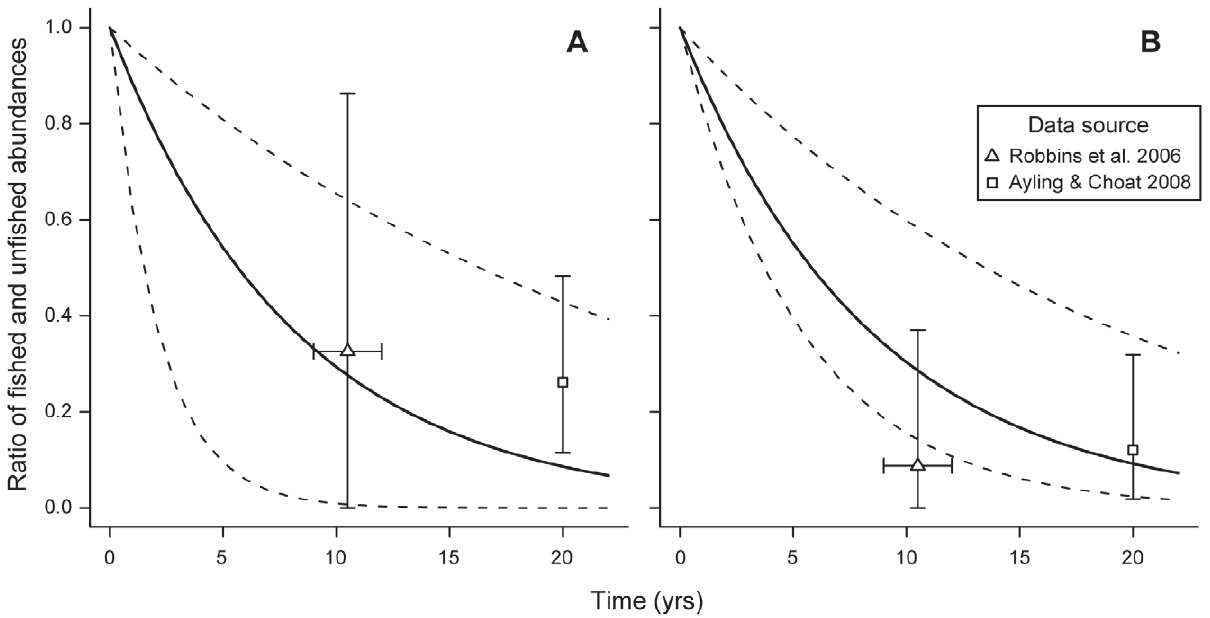
Figure 5. Estimates of ratio of fished to unfished abundances over time for two reef shark species. These estimates were calculated for (A) T. obesus and (B) C. amblyrhynchos on the Great Barrier Reef, from our bootstrap bias-corrected consensus estimates of long-term total and natural population growth rates (Equation 11). The dashed lines indicate 95% bias-corrected, accelerated (BCa) bootstrap confidence intervals on these abundance ratios. The mean differences between surveyed abundances on open fishing and unfished (no-entry) reefs are plotted as triangles and squares for the data in Robbins et al. [18] and Ayling and Choat [31], respectively. Location of triangles and squares on the horizontal axis reflects the number of years elapsed between establishment of the relevant no-entry zones, and the underwater surveys. For Robbins et al. [18], horizontal whiskers reflect the fact that surveys took place over a multi-year period (2001–2004). Vertical whiskers indicate 95% bootstrap confidence intervals on these abundance ratios, generated by Monte-Carlo simulation, as described in the Methods